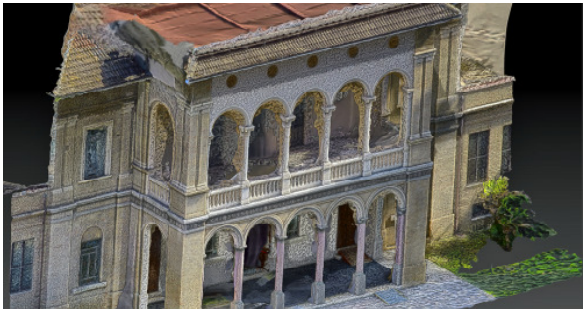
Figure 11. Phases of cleaning up of digital noise and semantic division of the 3d assets for the retopology in